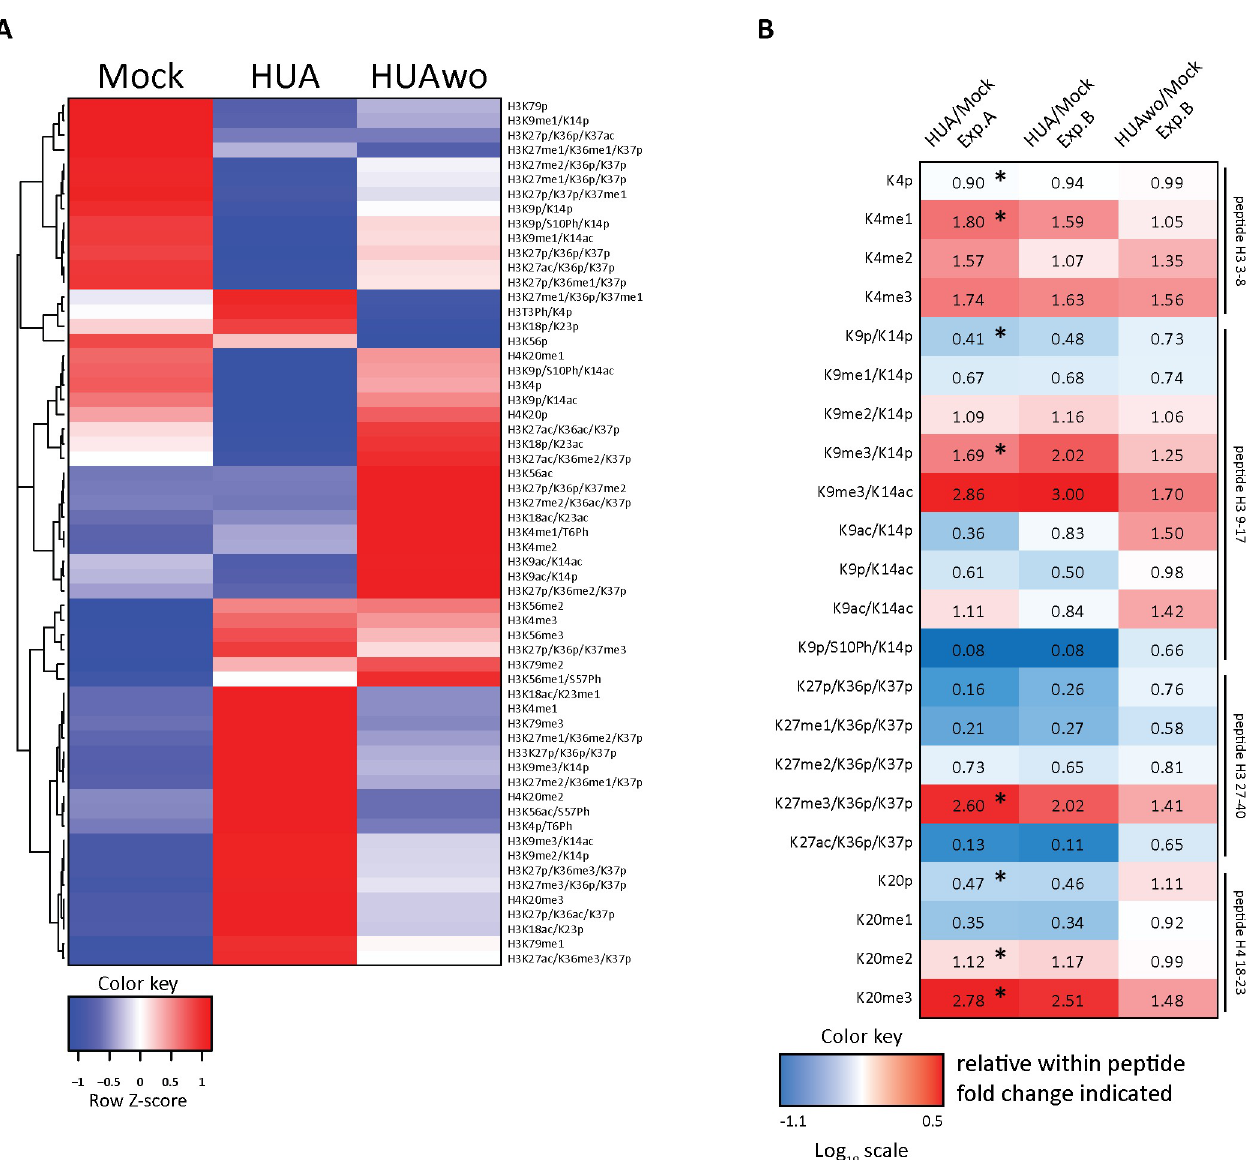
Fig 6. HUA effects on stage-specific HMPs are reversible. (A) Heatmap of the relative histone modification states abundance under the indicated conditions. As before, the relative distributions of the indicated modification states are calculated in percentages within each tryptic peptide. Data in columns are collected from early tadpole stage embryos NF32 ( n = 1 biological replicate), independently from the data of experiment type A. Note: Relative differences between Mock and HUA samples of experiment type B are highly similar to the results of experiment type A (S6 Fig). Color key, row Z-score. The individual quantitative observations can be found in S4 Data. (B) Ratio heatmap of relative histone modification abundance for selected histone marks. First, the relative distributions of the indicated modification states are calculated as percentages within each tryptic peptide (S6 Fig). Then, the relative values are presented as ratios between sample pairs indicated on top, showing the relative change for each histone modification state between the 2 conditions. Color key is based on the Log10 scale. Numerical values in the cells indicate the fold-change. “p,” propionylated (naturally unmodified). Values greater than 1.0 indicate an increase in HUA condition; values smaller than 1.0 indicate a higher abundance in Mock condition. NA, not applicable, when values in Mock were 0. The first 2 columns illustrate the similarity between experiment types A and B; the information in the third column shows the similarity between HUAwo and Mock samples. Asterisks ( � ), adj. p < 0.1 (Benjamini–Hochberg procedure) between indicated conditions. The direct comparison of relative histone PTMs abundance is shown in S6 Fig. HMP, histone modification profile; HUA, hydroxyurea and aphidicolin; HUAwo, HUA